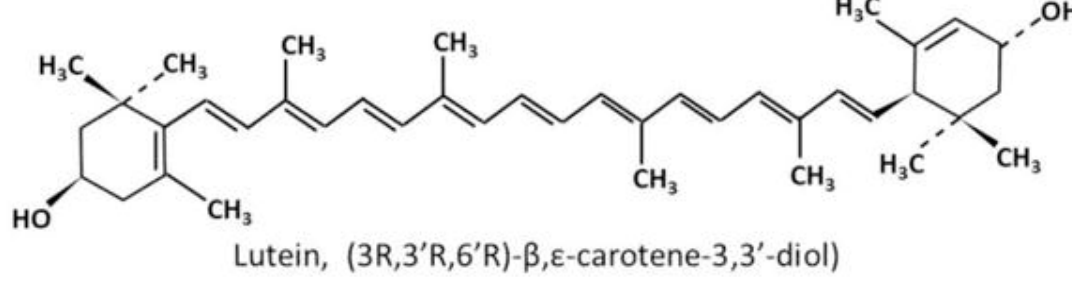
Figure 1. Chemical structure of lutein [29].